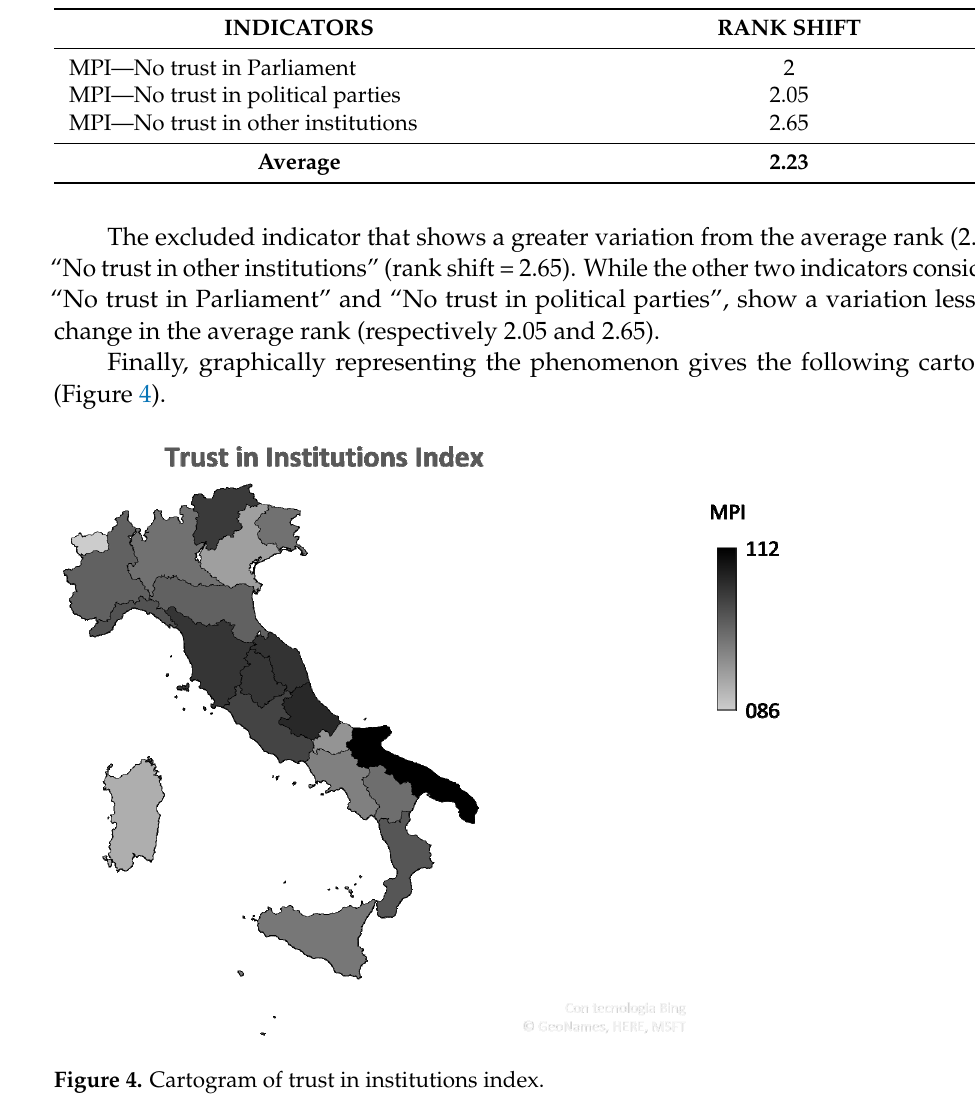
Figure 4. Cartogram of trust in institutions index.